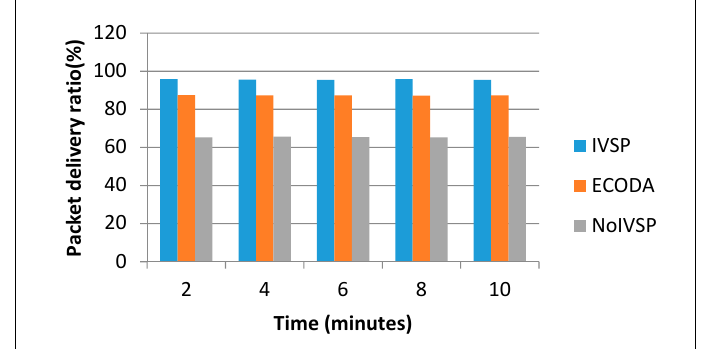
Figure 11. Packet Delivery ratio of P Frame packets.